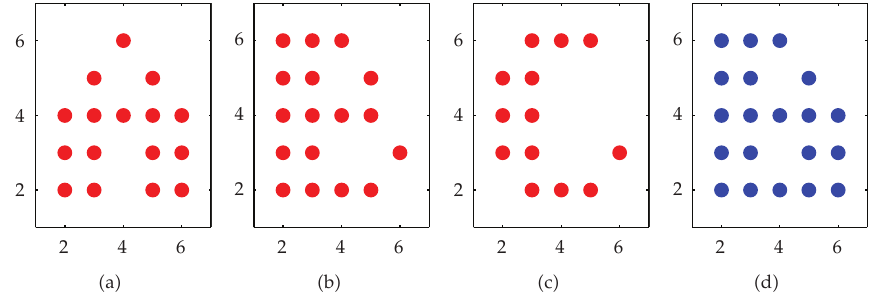
Figure 7: (cid:3) a (cid:4) – (cid:3) c (cid:4) The training set, (cid:3) d (cid:4) the input superimposed pattern.